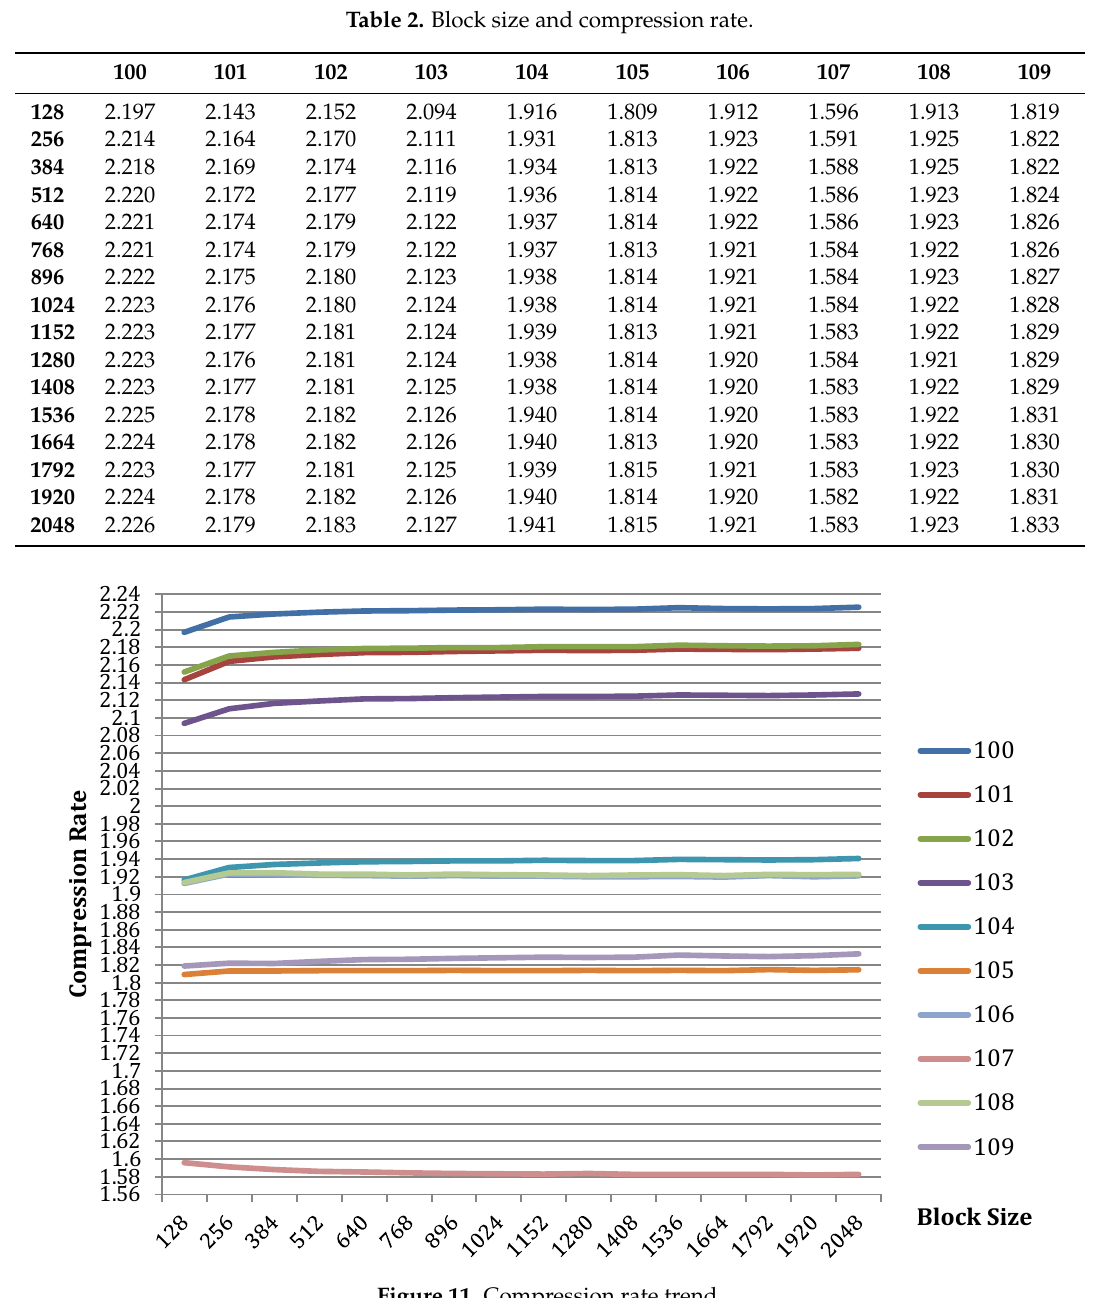
Figure 11. Compression rate trend.